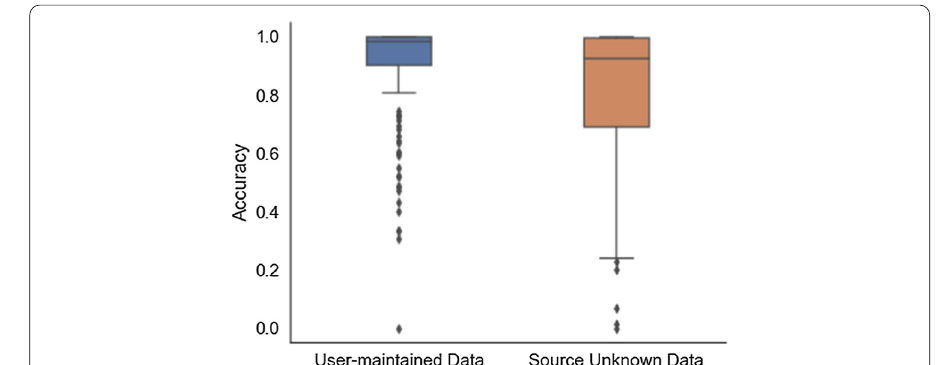
Fig. 11 Average result of maintained classification and unknown classification